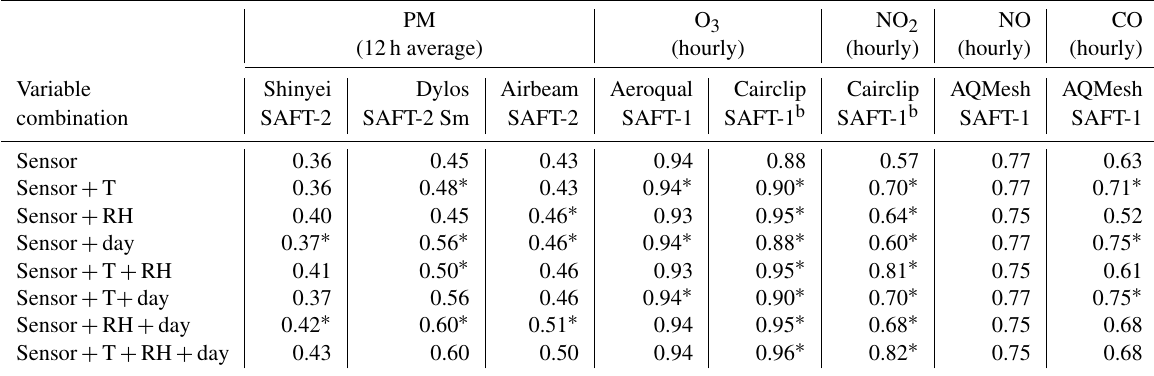
Table 5. Comparison of adjusted regression coefficients ( R 2 individual sensor a , ambient temperature, humidity, and/or number of measurement